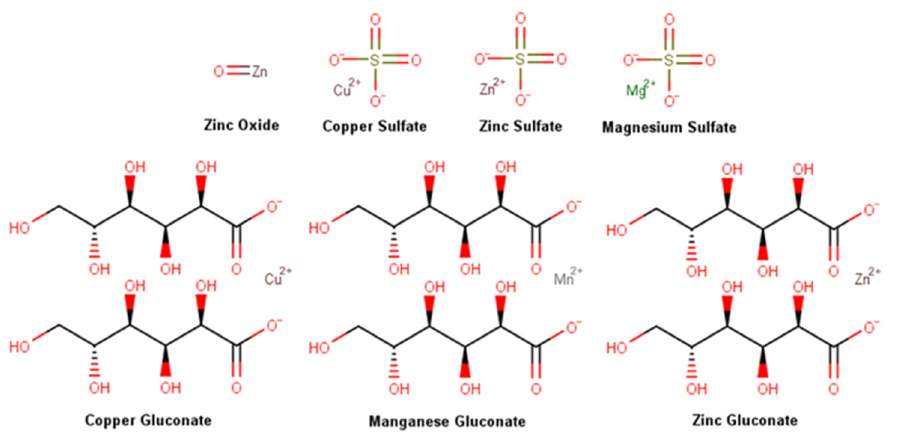
Figure 8. Chemical structure of the metal salts and oxides.